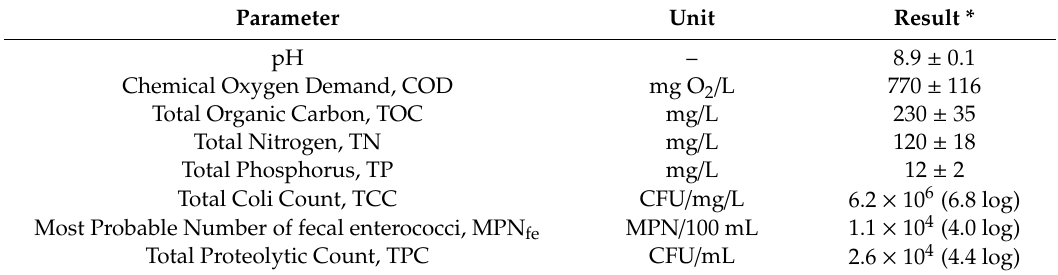
Most Probable Number of fecal enterococci, MPN